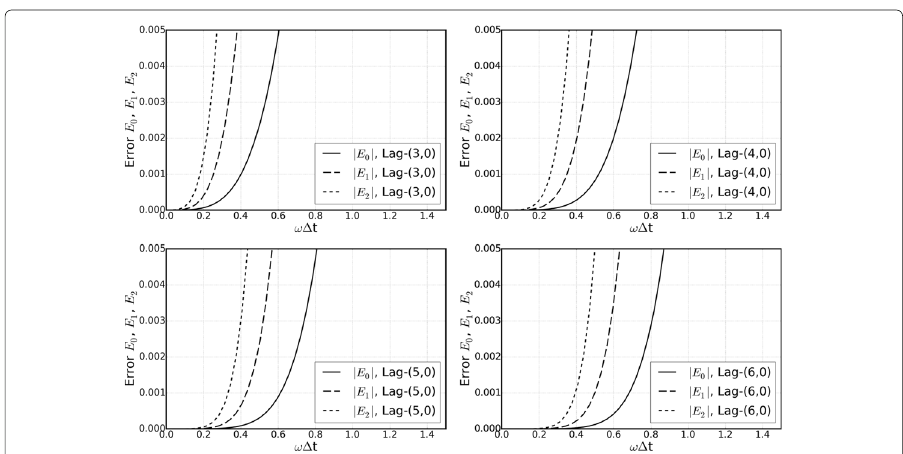
Fig. 3 Maximum of error functions E 0 (η , ξ) , E 1 (η , ξ) and E 2 (η , ξ) for 0 ≤ η < 1 as a function of ξ = ω(cid:4) t , for Lagrange schemes Lag-(3,0), Lag(4,0), Lag-(5,0), and Lag-(6,0) as